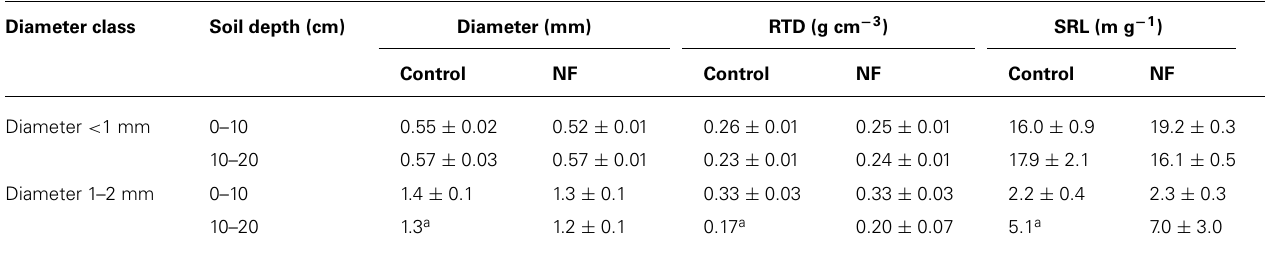
Table 5 | Morphological parameters of fine roots of sugi at control and nitrogen-fertilized (NF) plots.